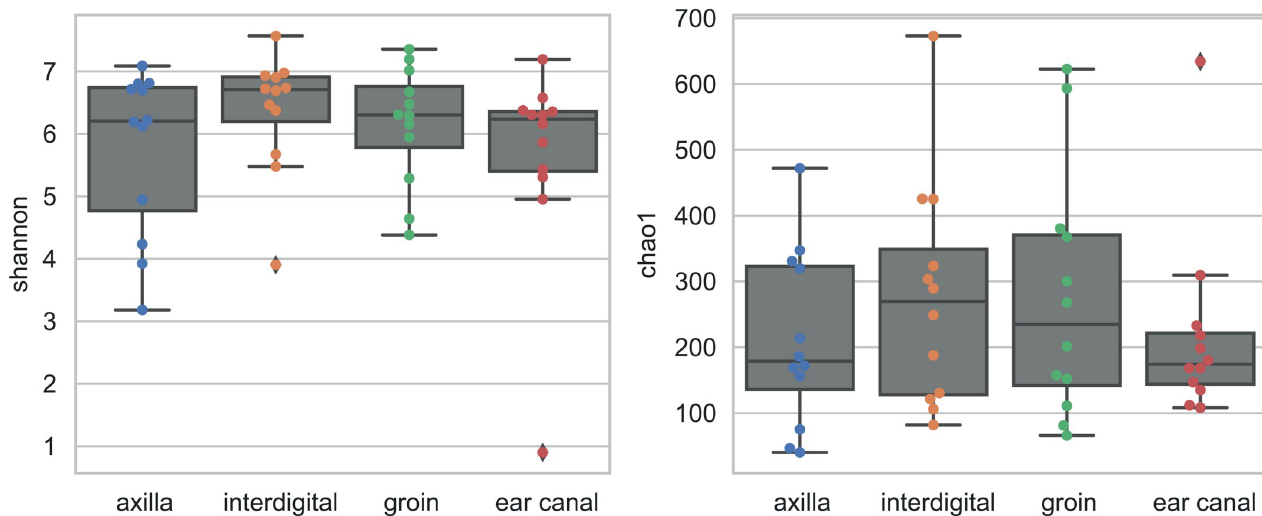
Fig 1. Box-plots of alpha diversity indices Shannon (a) and Chao1 (b) for the four studied body sites of non-allergic dogs. No significant differences were obtained between the body sites using Kruskal-Wallis tests.